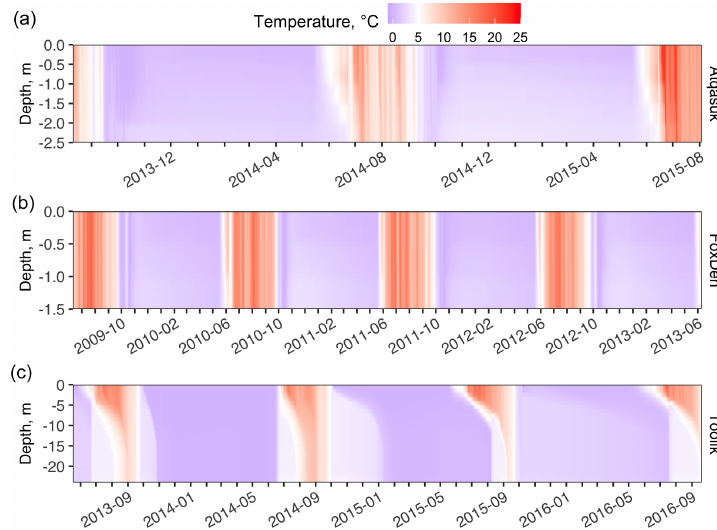
Figure C1. Baseline lake water temperature over the simulation period for Atqasuk (a) , Fox Den (b) , and Toolik Lake (c) .